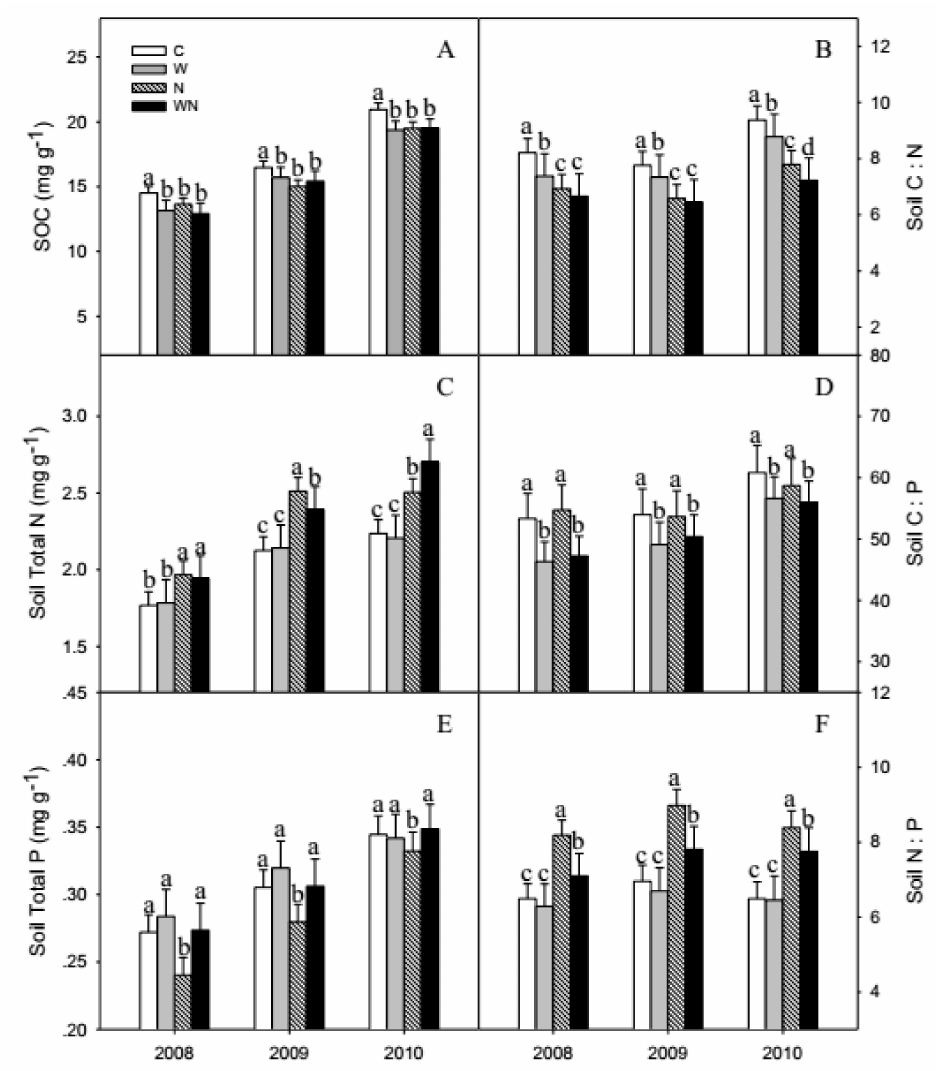
Figure 3. Responses of SOC ( A ), soil total N ( C ), total P ( E ) contents and C:N ( B ), C:P ( D ), N:P ( F ) stoichiometry to warming and N addition. Vertical bars represent the standard error of the mean (n = 6). Di ff erent lowercase letters indicate significant di ff erences ( P < 0.05). See Figure 2 for